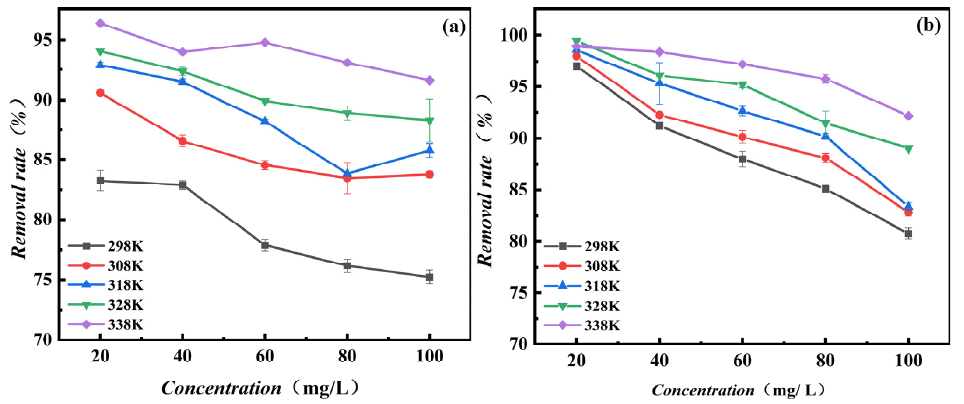
Figure 10. Effect of the concentration for the adsorption of MB onto BC ( a ) and Fe 3 O 4 -MOS ( b ) at 20, 40, 60, 80and 100 mg/L dye solutions.